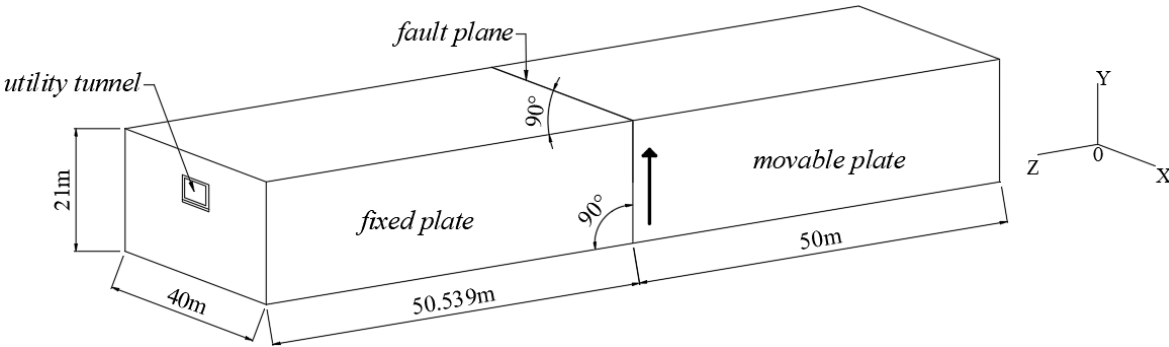
Figure 2. Overall schematic diagram of the numerical mode.